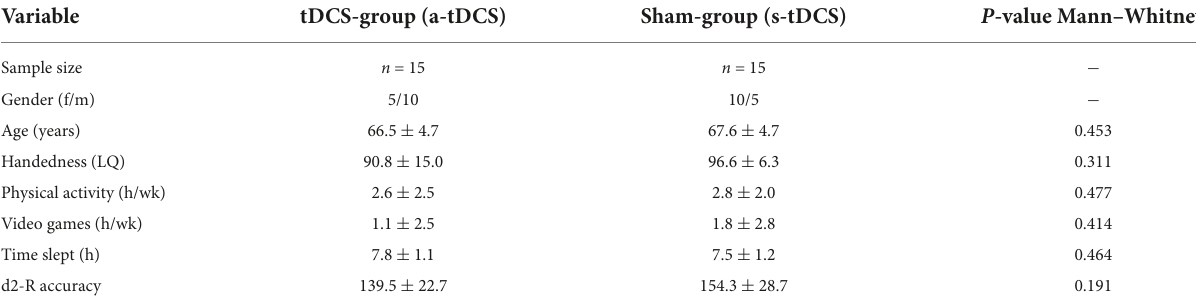
TABLE 1 Overview of participant characteristics for both groups (a-tDCS and s-tDCS).